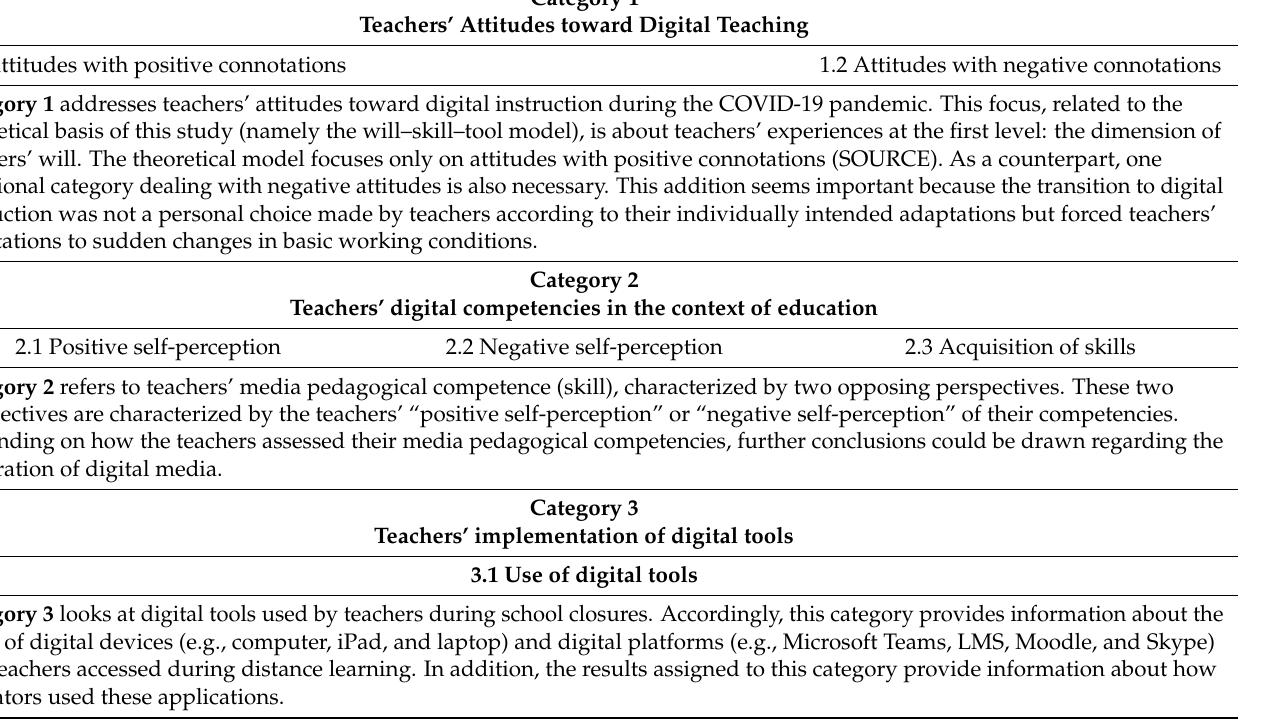
Table 2. Categories created during data